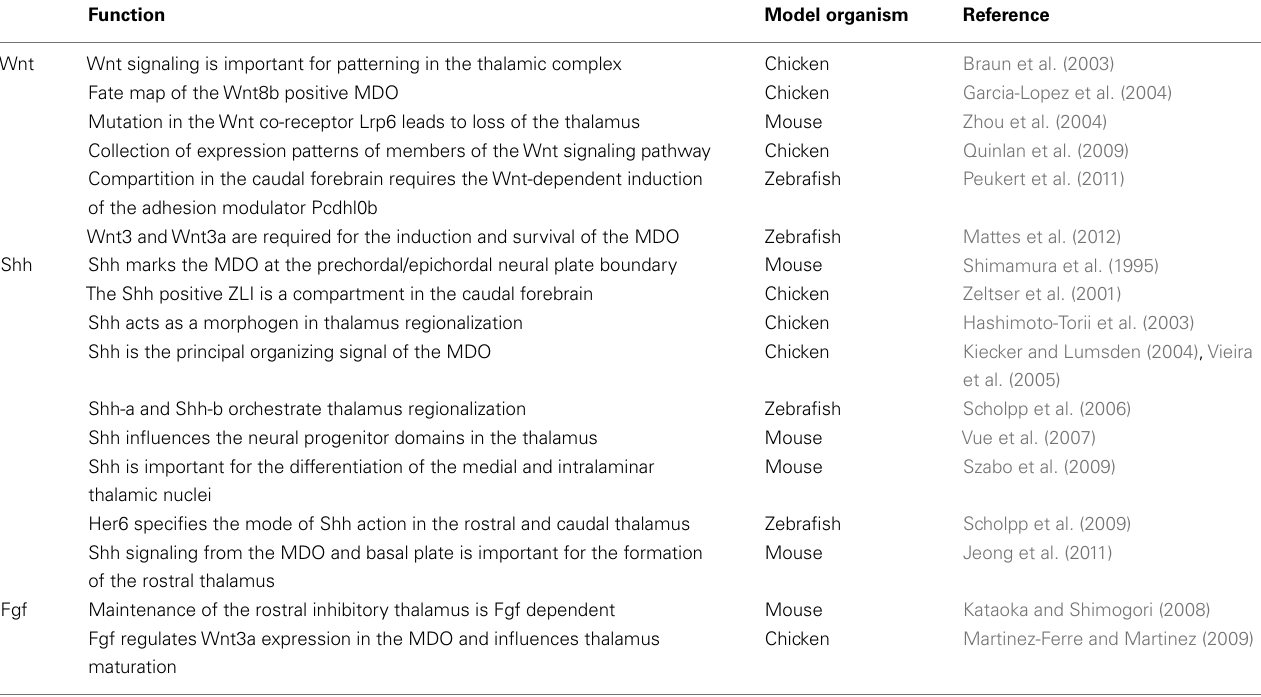
Table 1 | Summary of functions of the three signaling pathways during thalamus development with related animal models in chronological order of